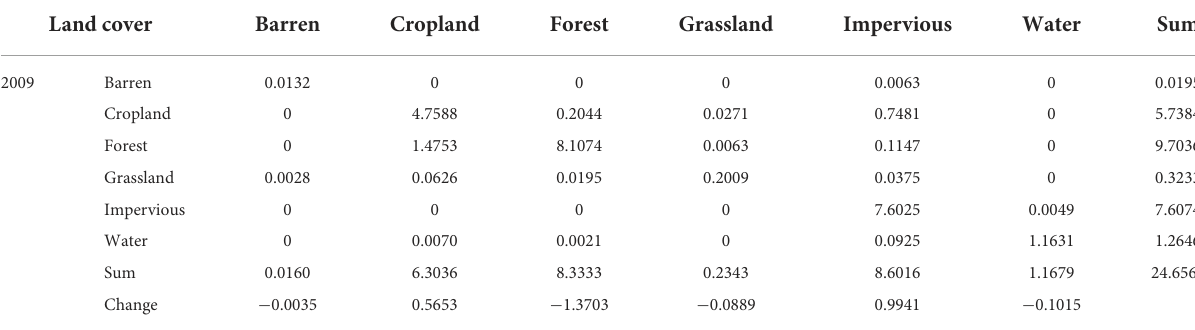
TABLE 6 Land use change from 2009–2019 (km 2